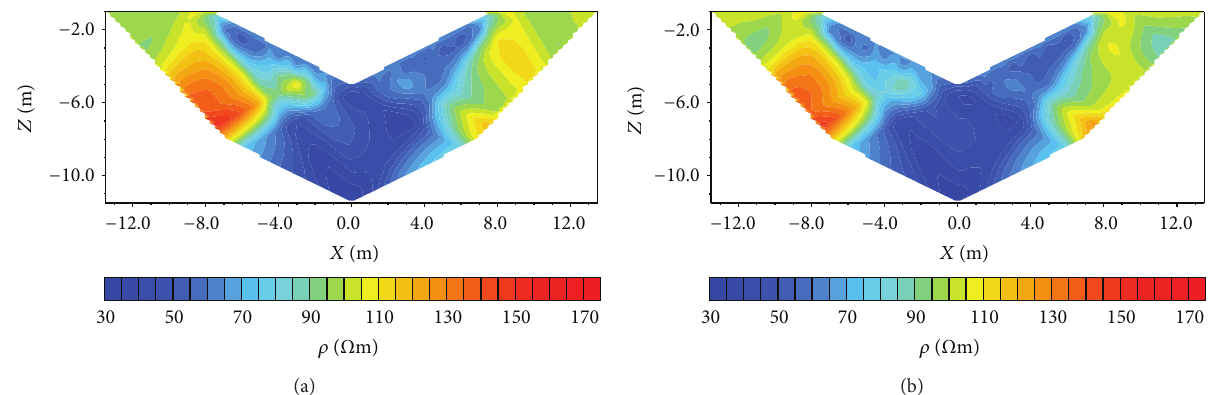
Figure 8: A comparison between observed apparent resistivity (a) and predicted apparent resistivity (b) for profile 𝑌 = 0 .